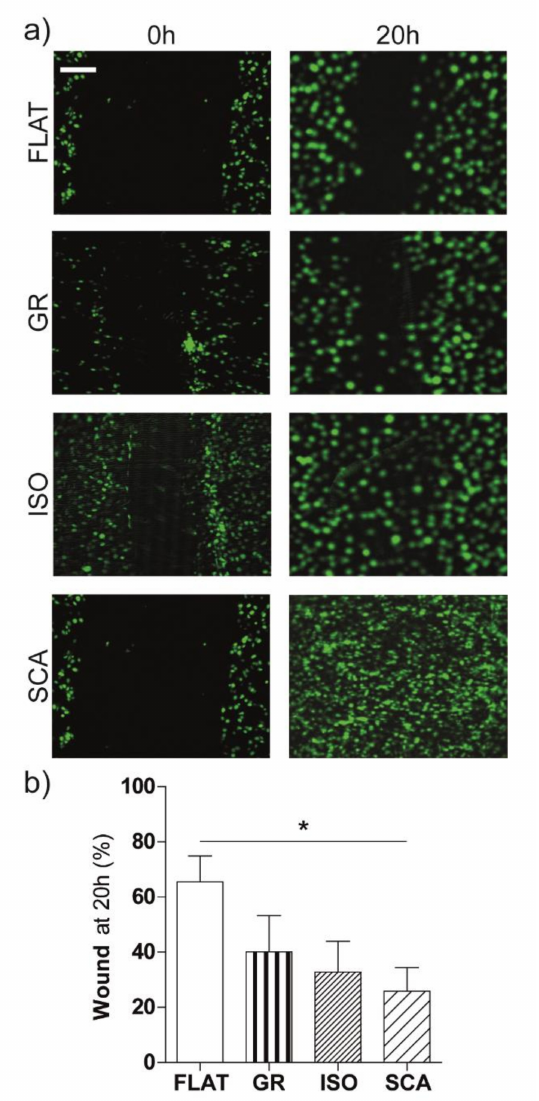
Figure 6. Collective cell migration. ( a ) Fluorescence microscopy images of the wound-healing experiments at t = 0 h and t = 20 h from the gap opening. The RT4-SC nuclei are visible in green (GFP) on the micro-structured chitosan films (GR, ISO and SCA) and on the FLAT control; scale bar = 100 µ m. ( b ) Wound-healing quantification: the percentage of the wound area at t = 20 h was reported as a % in respect to the initial wound area (t = 0 h). * p < 0.05 FLAT vs. SCA, one-way ANOVA, Bonferroni’s test. Data = mean ± SEM, n ≥